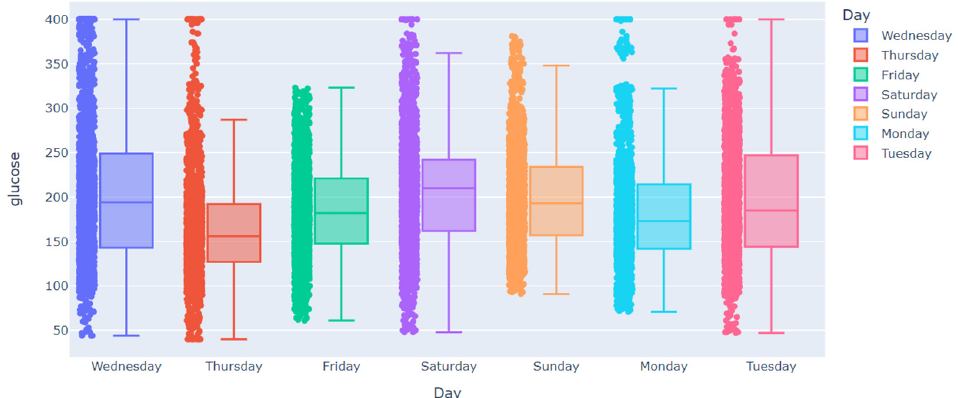
show a cyclic pattern during the week with a peak on two days: Wednesday and Saturday. This pattern shows the seasonality of the CGM time series according to the day of the week.